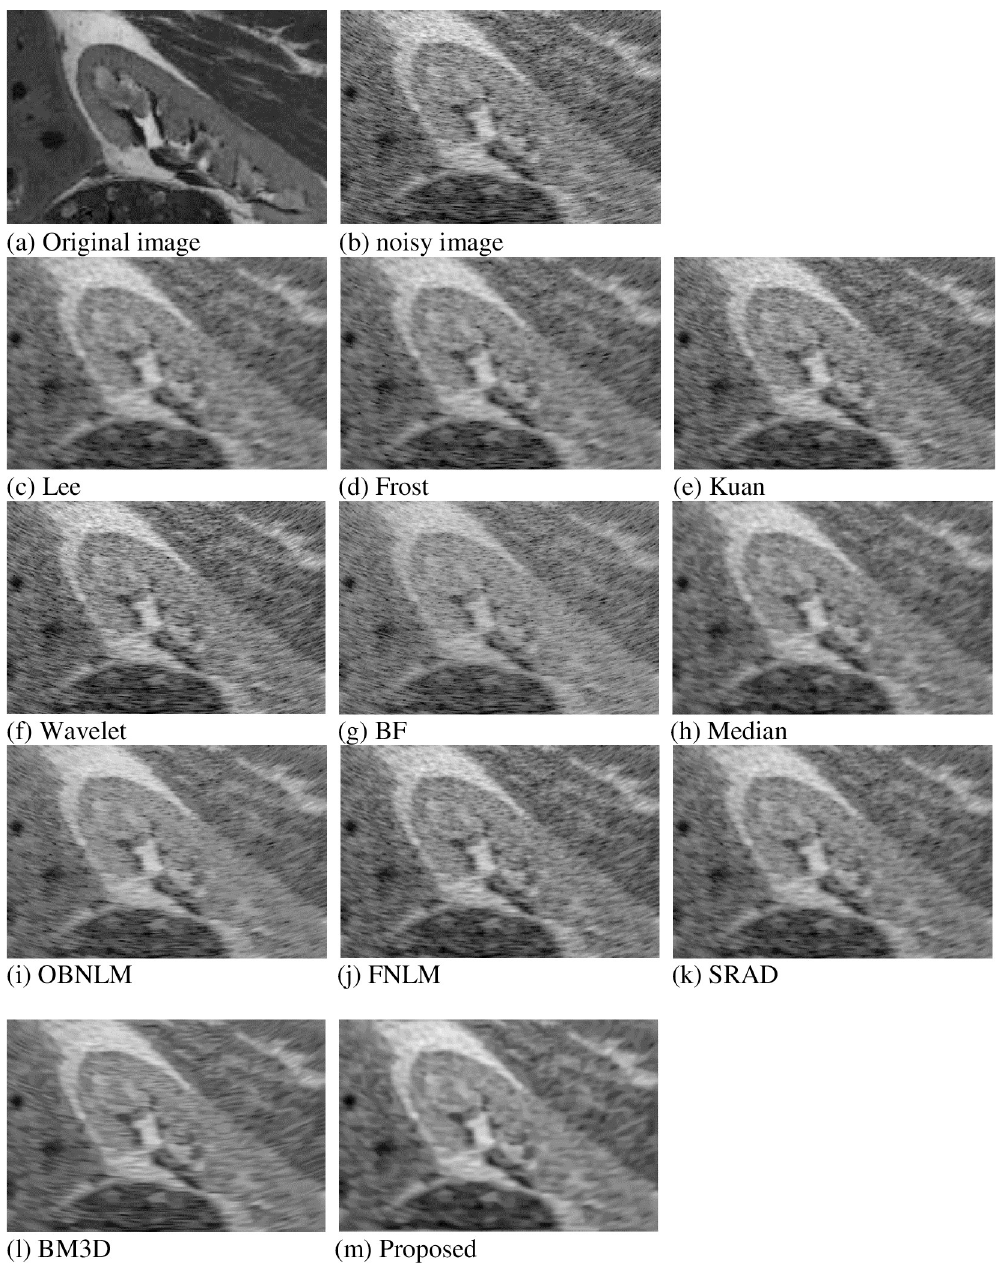
Fig 8. Denoising comparison of simulation